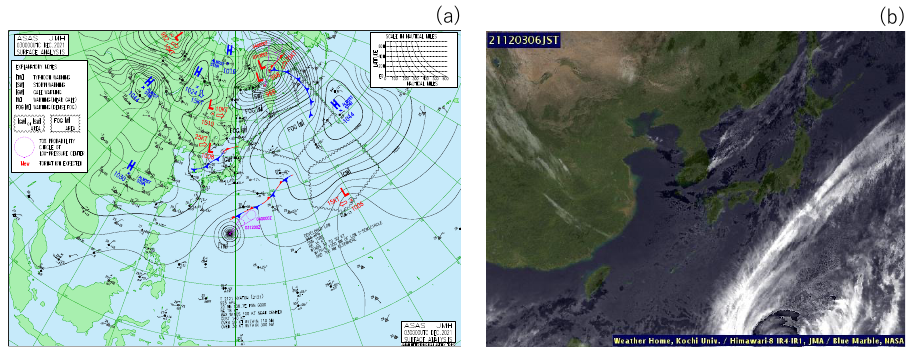
Figure 6. ( a ) A weather map and ( b ) a IR weather satellite image around the time of EQ1.